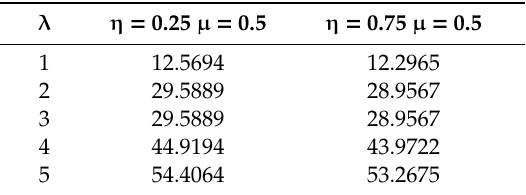
First five natural frequencies for the SFG distribution for two di ff erent states of partial agglomeration.